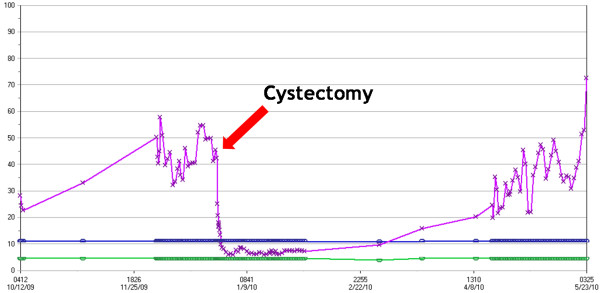
Graphical representation of the trend of white blood cell counts before and after cystectomy (see arrow). X axis represents time and Y axis represents white blood cell count in K/UL. Green and blue lines represent the normal range of white blood cell count. Pink line represents the trend in the patient’s white blood cell count.